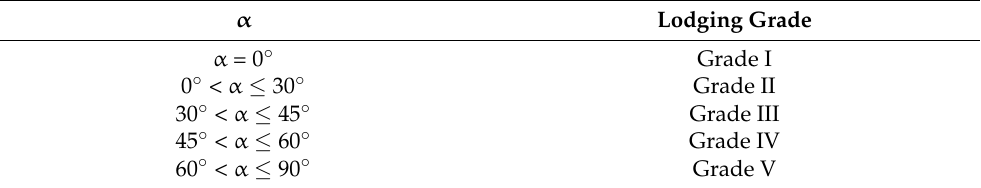
Table 1. Wheat lodging grade classification criteria.